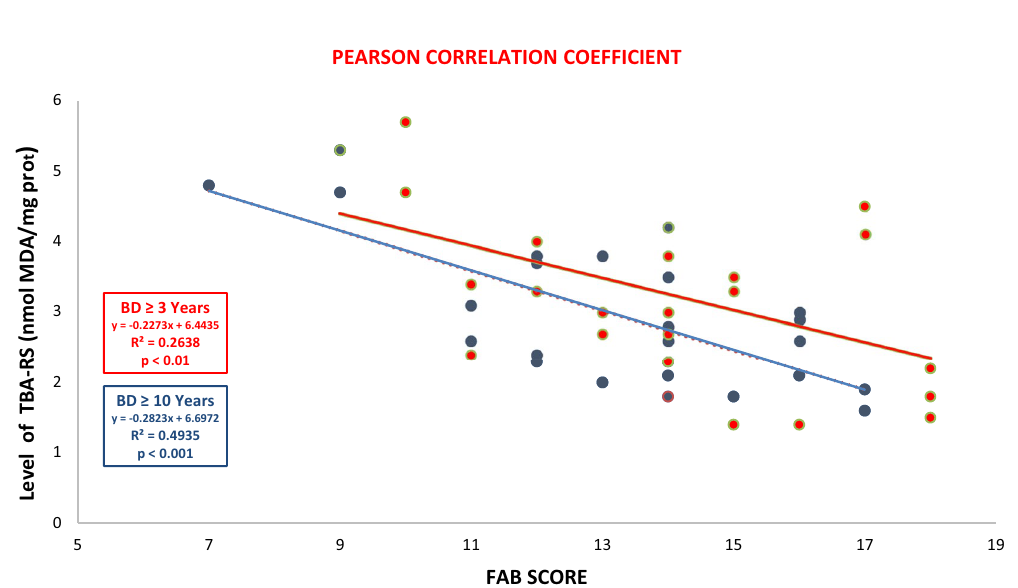
Figure 2. Correlation between Levels of TBA-RS and FAB test scores between BD patients ≤ 3 years (in red) and ≥ 10 years of the disease (in blue) using the Pearson correlation